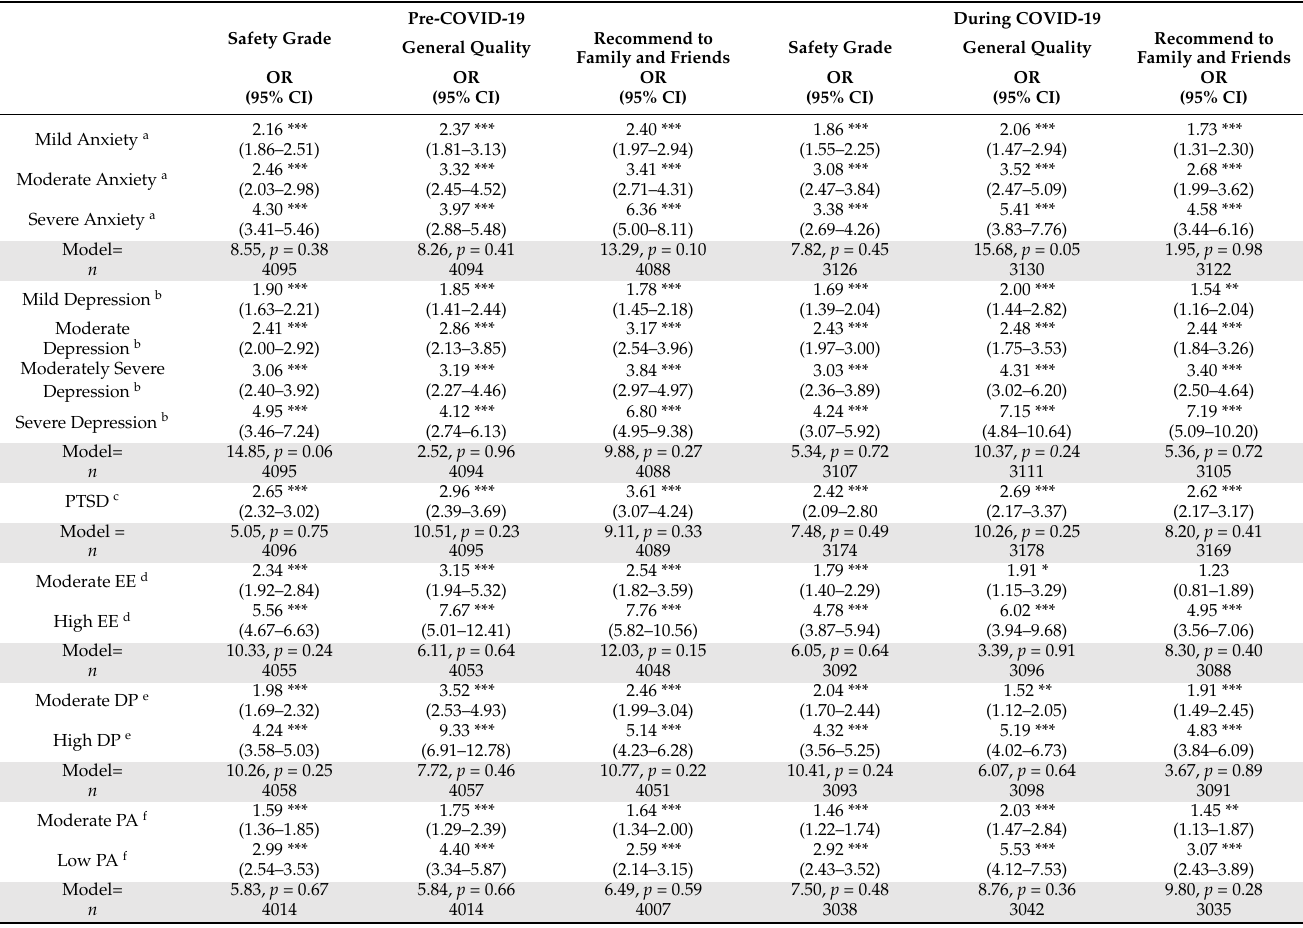
Table 3. Mental health symptoms severity as predictors of nursing quality and safe patient care delivery before and during